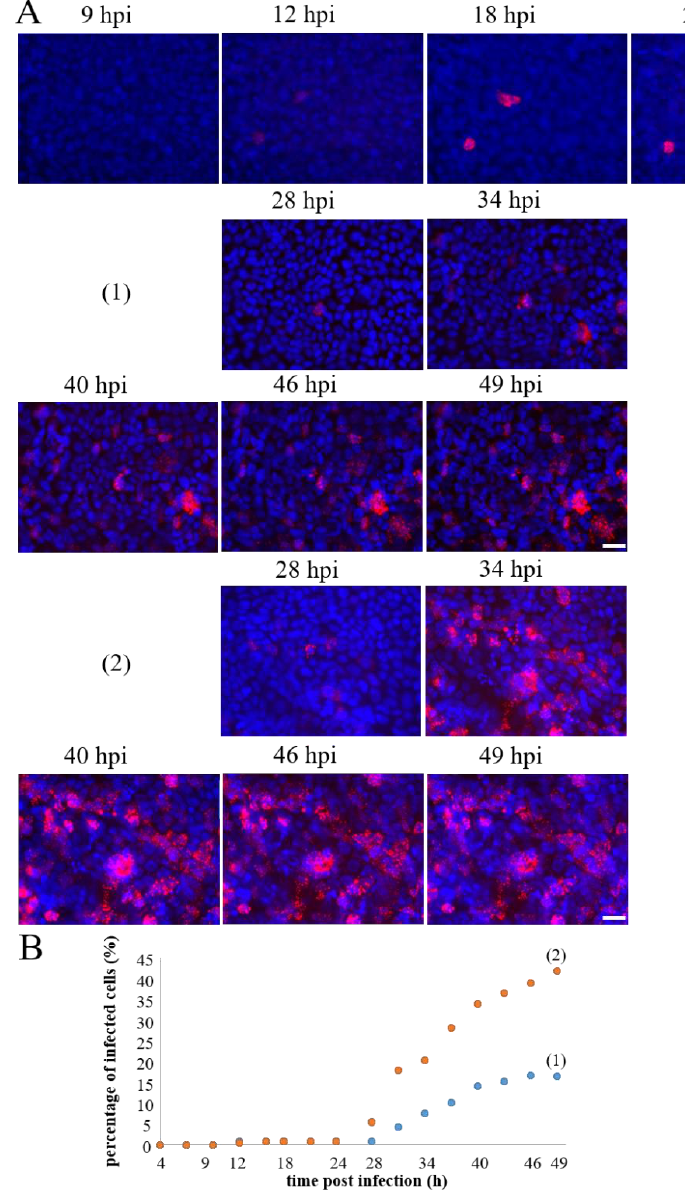
Figure 6. Real-time fluorescence imaging of NS1-RFP IAV infection in 3D submerged models using an MOI of 0.01. ( A ) Representative examples of time-lapse sequences were recorded between 9 to 24 hpi and 28 to 49 hpi, respectively. These models were pre-cultivated for 18 days and showed the first NS1-RFP fluorescence between 9 and 12 hpi. From 28 hpi onwards, the percentage of NS1-RFP-positive cells gradually increased (example (1) and (2)). ( B ) Quantification of the percentage of infected cells of these positions was between 4 and 49 hpi. The percentage of NS1-RFP-positive cells was calculated by cell counting of the total cell number (Hoechst-positive nuclei) and the NS1-RFP-positive cells in the respective images. Scale bars represent 25 µm.